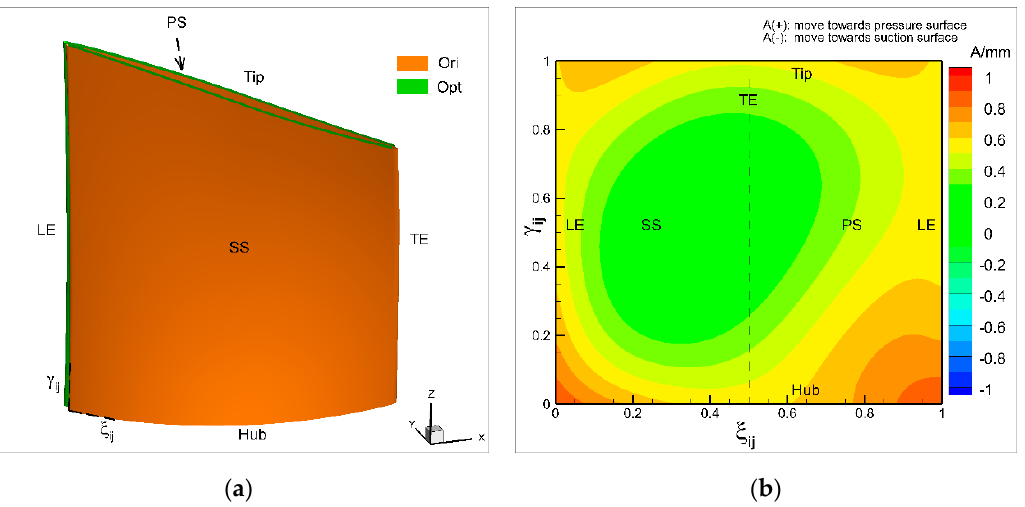
Figure 10. Comparison of suction and pressure surface of the original and optimized second-stage rotor. ( a ) Three-dimensional modeling diagram of the original second-stage rotor and the optimized second-stage rotor; ( b ) the circumferential fluctuation amount A of the optimized second-stage rotor compared with the original second-stage rotor.